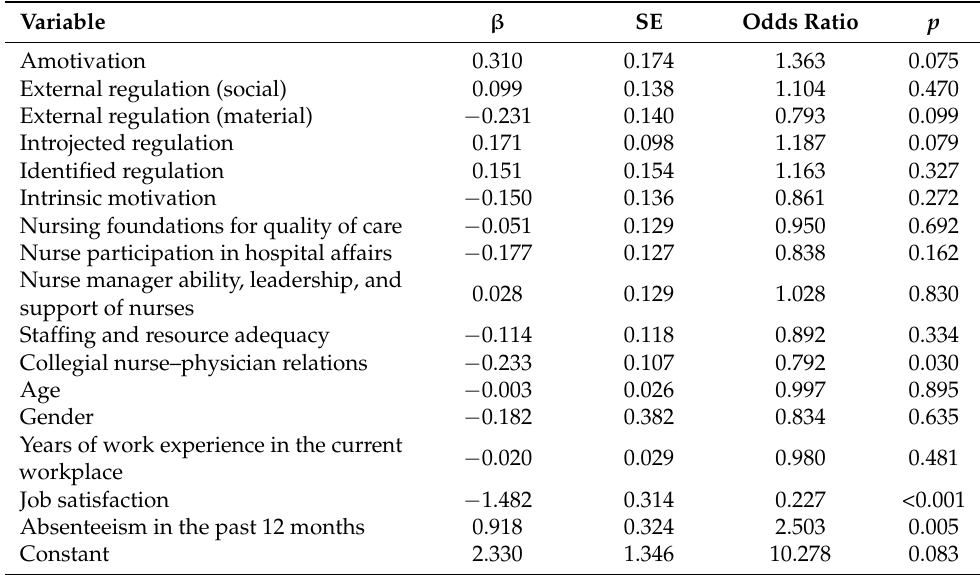
Table 2. Binary regression prediction model for turnover intention.